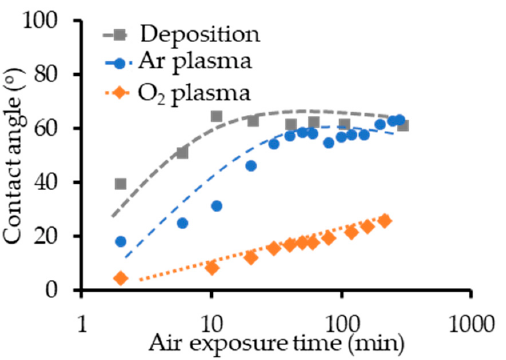
Figure 3. Typical images of measured contact angle: ( a ) without plasma treatment; ( b ) with 30 s Ar plasma treatment; ( c ) with 30 s O 2 plasma treatment.